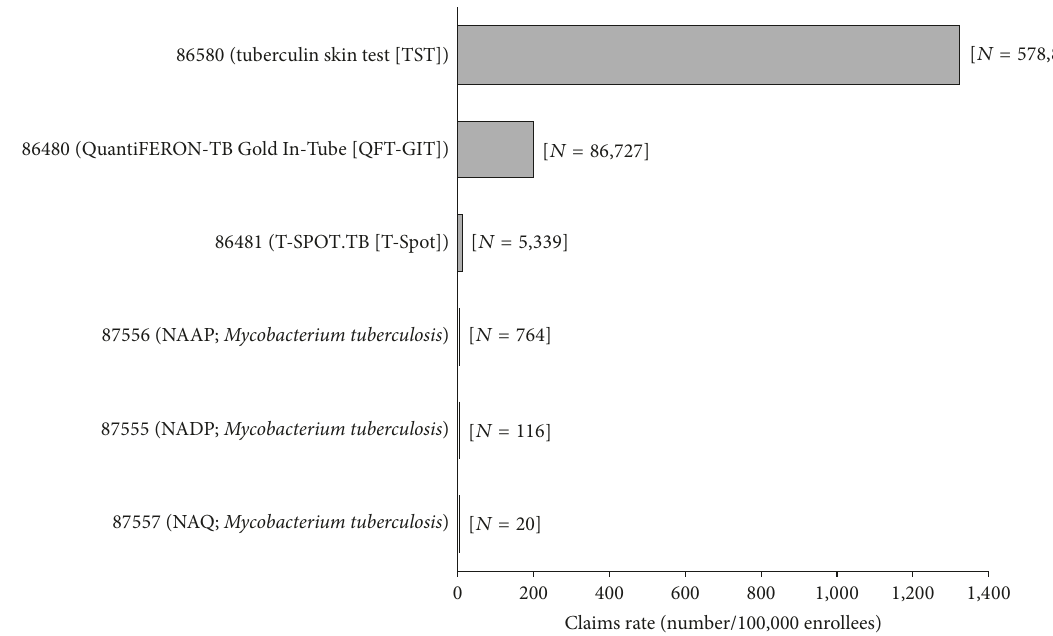
Figure 1: Estimated claims rates (number/100,000 enrollees) for the TB-specific tests. TB, tuberculosis; NAAP, nucleic acid amplification probe; NADP, nucleic acid direct probe; NAQ, nucleic acid quantification. The brand names for the respective IGRA testing method CPT codes (i.e., QuantiFERON-TB Gold In-Tube [QFT-GIT] for 86480 and T-SPOT.TB [T-Spot] for 86481) were used because they were the only IGRA tests approved by the Food and Drug Administration (FDA) as of 2013 [7].